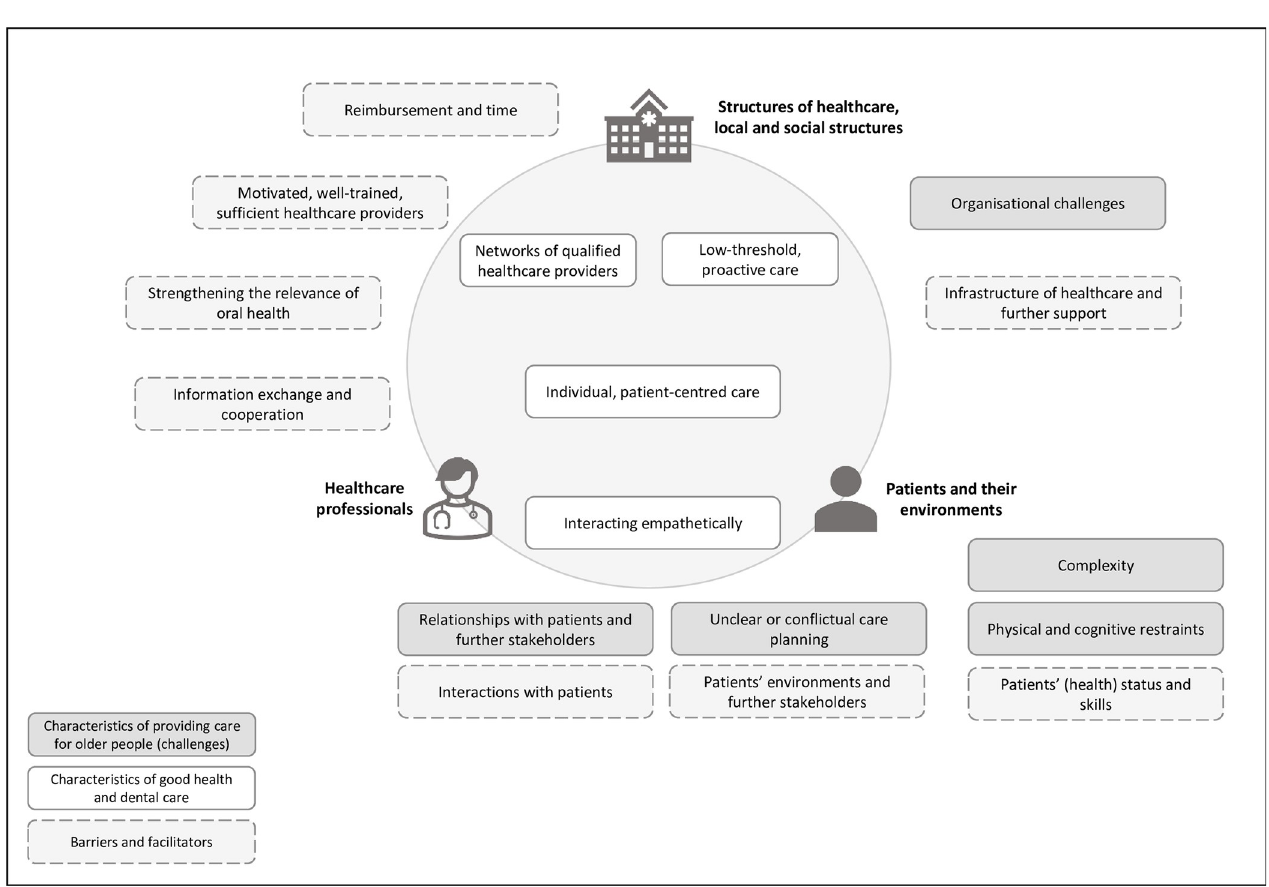
Fig 2. Overview of